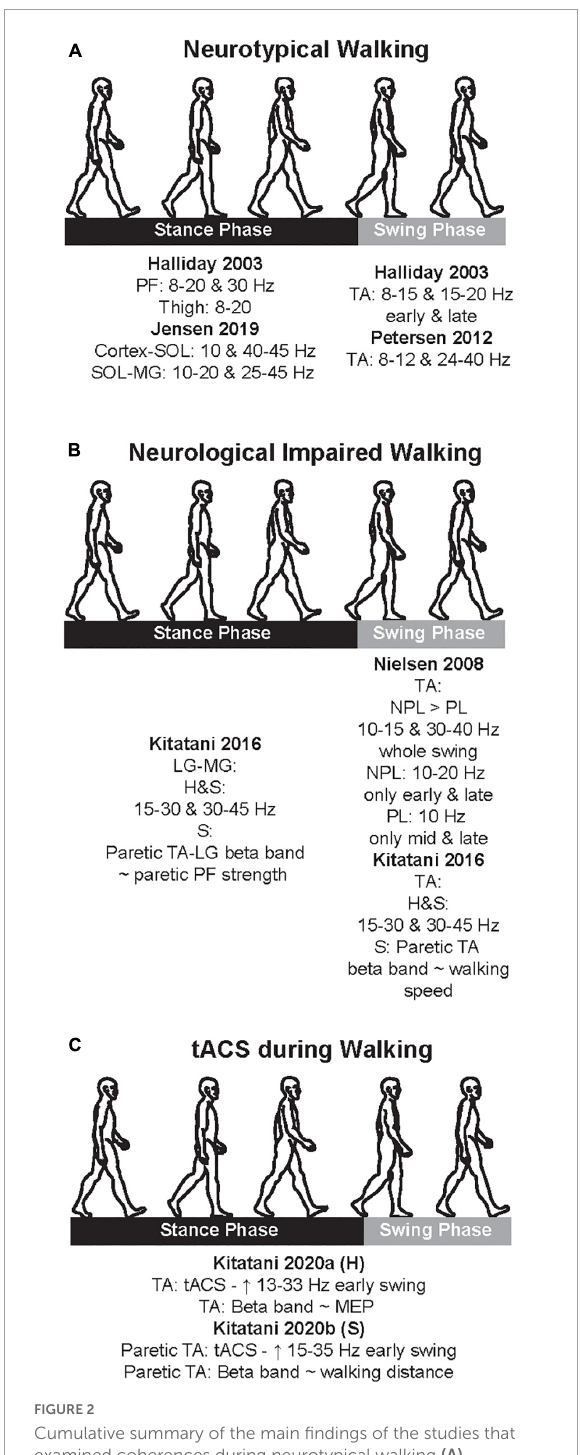
FIGURE2 Cumulative summary of the main findings of the studies that examined coherences during neurotypical walking (A) , neurological impaired walking (B) , and transcranial alternate current stimulation (tACS) application (C) . Here, we just present the main findings; see text for further details. PF, plantarflexors; TA, tibialis anterior; LG, lateral gastrocnemius; MG, medial gastrocnemius; H, healthy; S, stroke; NPL, non-paretic leg; PL, paretic leg; ∼ , significant correlation; MEP, motor evoked